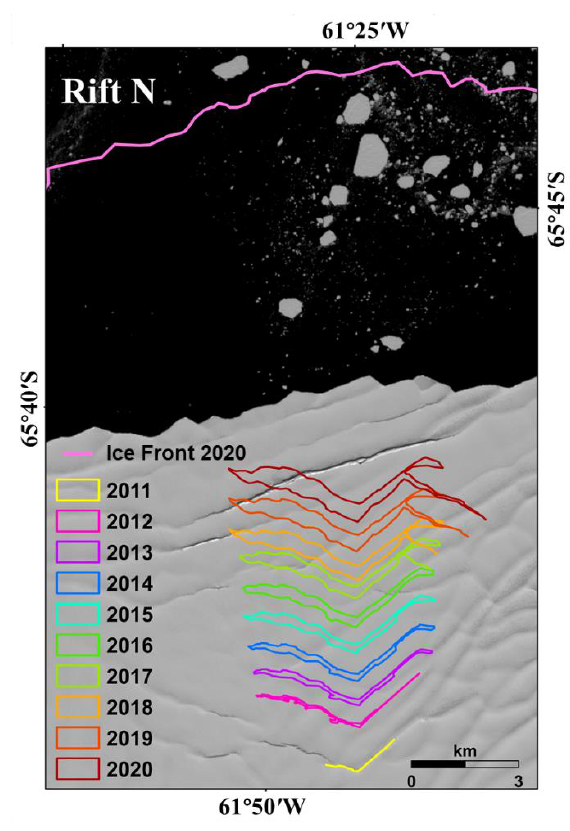
Figure 2 . Evolution for Rift N (Figure 1) in the Scar Inlet Ice Shelf from 2011 to 2020. The background image is Landsat image acquired on 26 February